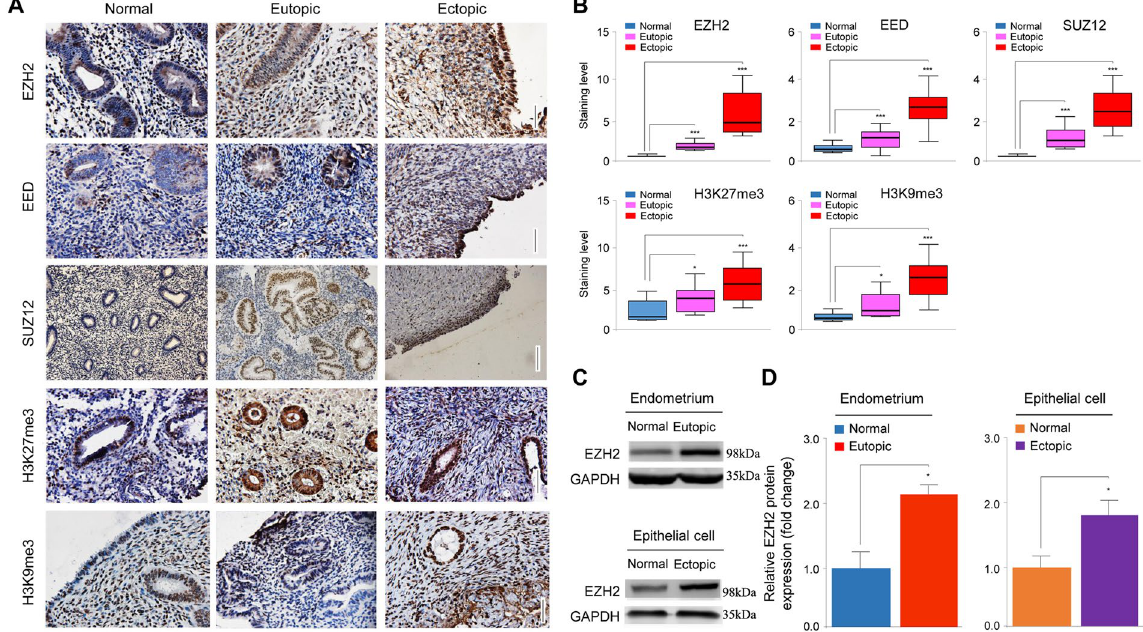
Figure 1. EZH2 expression is elevated in both ectopic and eutopic endometrium of women with endometriosis. ( A ) Immunostaining of normal endometrium, eutopic and ectopic endometrium from patients with endometriosis with antibodies for EZH2, EED, SUZ12, H3K27me3 and H3K9me3 (X400; Scale bar = 125 μ m). ( B ) Quantitative comparison of EZH2, EED, SUZ12, H3K27me3 and H3K9me3 protein expression between normal endometrium, eutopic and ectopic endometrium from patients with endometriosis. ( C , D ) Representative images ( C ) and quantitative comparison ( D ) of EZH2 protein expression in the whole tissue (including epithelial and stromal cells) between normal and eutopic endometrium (n = 7 each), and in epithelial cells between normal and ectopic endometrium (n = 7 each). The cropped blots are used in the figure.